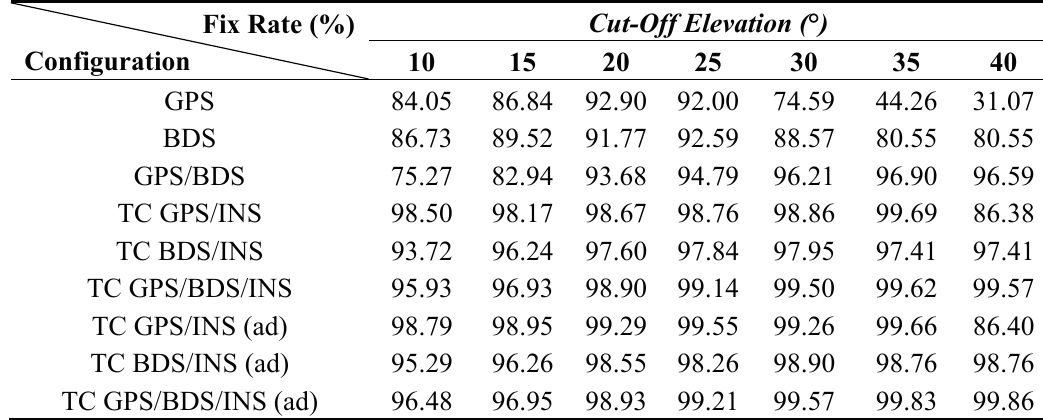
Table 3. Ambiguity fixing rate of the dynamic test for 10°–40° cut-off elevations, using different data process strategies.